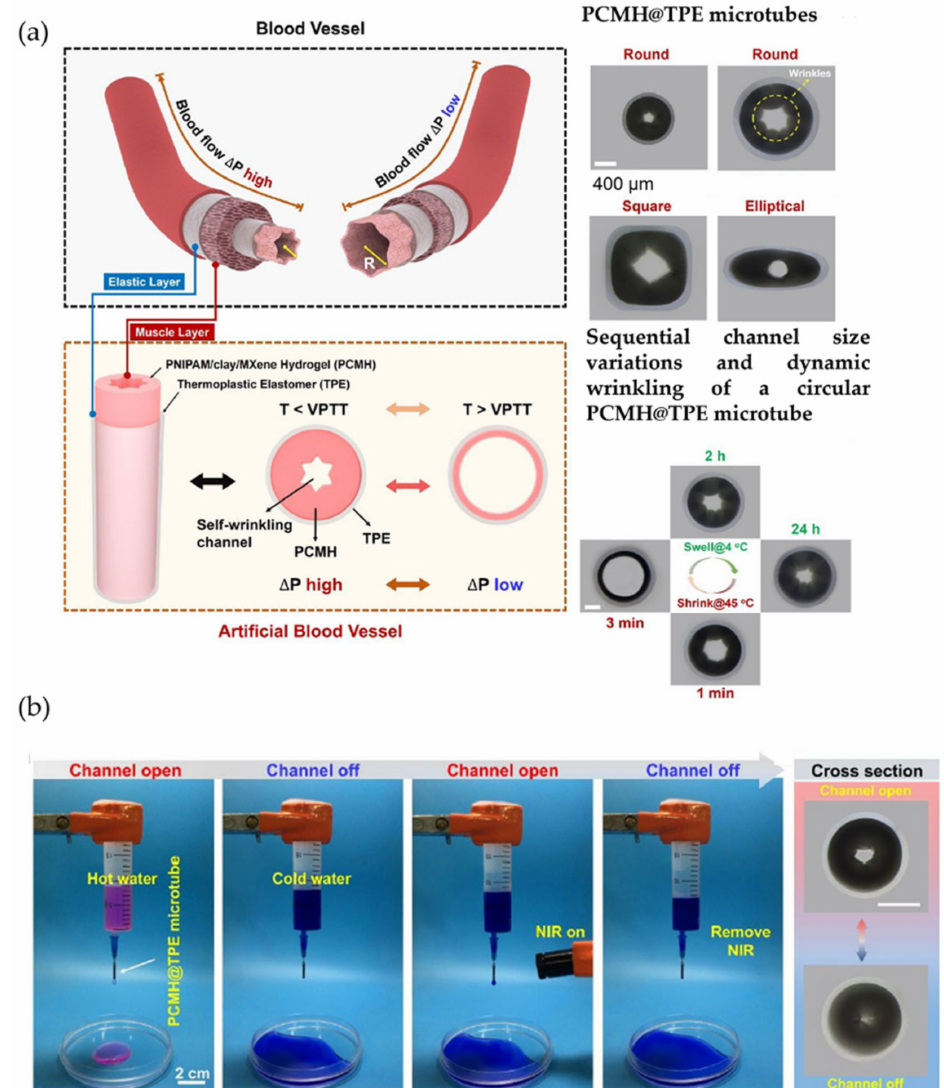
Figure 30. ( a ) Schematic illustration of the layered structure, hydraulic pressure sensing, and ac- tuating functions of artery walls as well as an artificial blood vessel, PCMH@TPE microtube, and ( b ) photographs of PCMH@TPE microtube as a smart microvalve for controlling water flow with the channel open/closed by hot/cold water and re-opened/re-closed by irradiation or remotion of NIR. Reproduced with permission from reference [122]. Copyright 2022, Elsevier